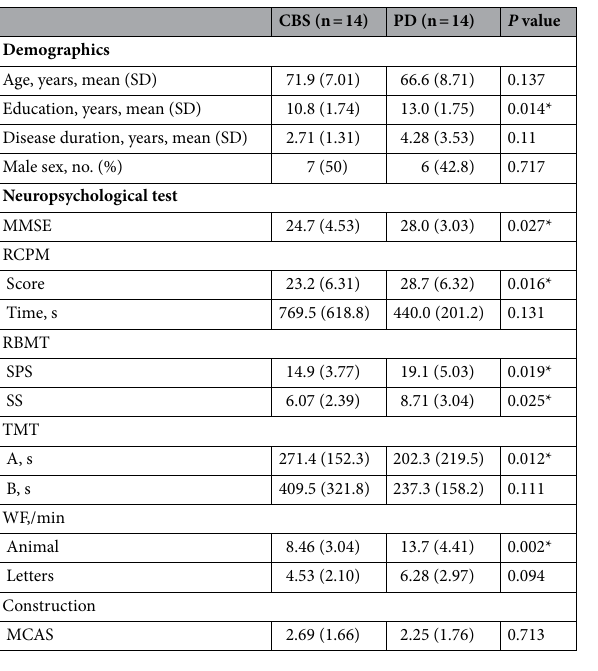
Table1. Characteristics and neuropsychological assessments of the patients. MCAS Mie Constructional Ability Scale, MMSE Mini-Mental State Examination, RBMT Rivermead Behavior Memory Test (SPS: Standard profile score, SS: Screening Score) , RCPM Raven’s Colored Progressive Matrices, s seconds, TMT Trail-Making Test, WF word fluency. *Statistically